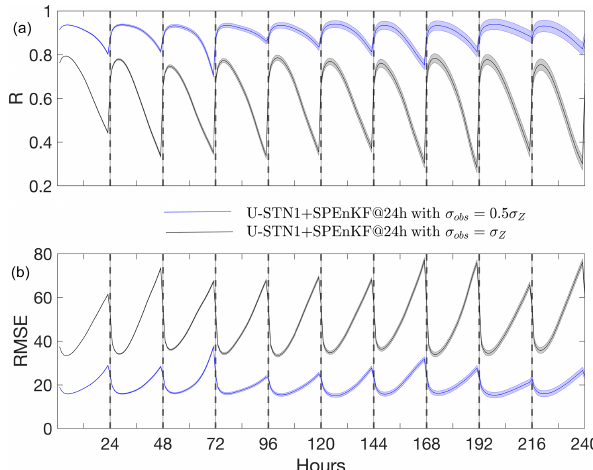
Figure 5. Panel (a) shows R and panel (b) shows RMSE (in me- ters) between noise-free data from ERA5 and the forecasts from U-STN1+SPEnKF for two levels of observation noise. Predictions are started from 30 random noisy observations. The lines (shading) show the mean (standard deviation) of the 30 forecasts. Noisy ob- servations are assimilated every 24h (indicated by black, dashed vertical